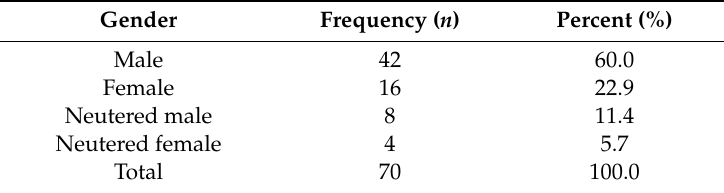
Table 3. Gender of dogs aggressive towards other dogs.